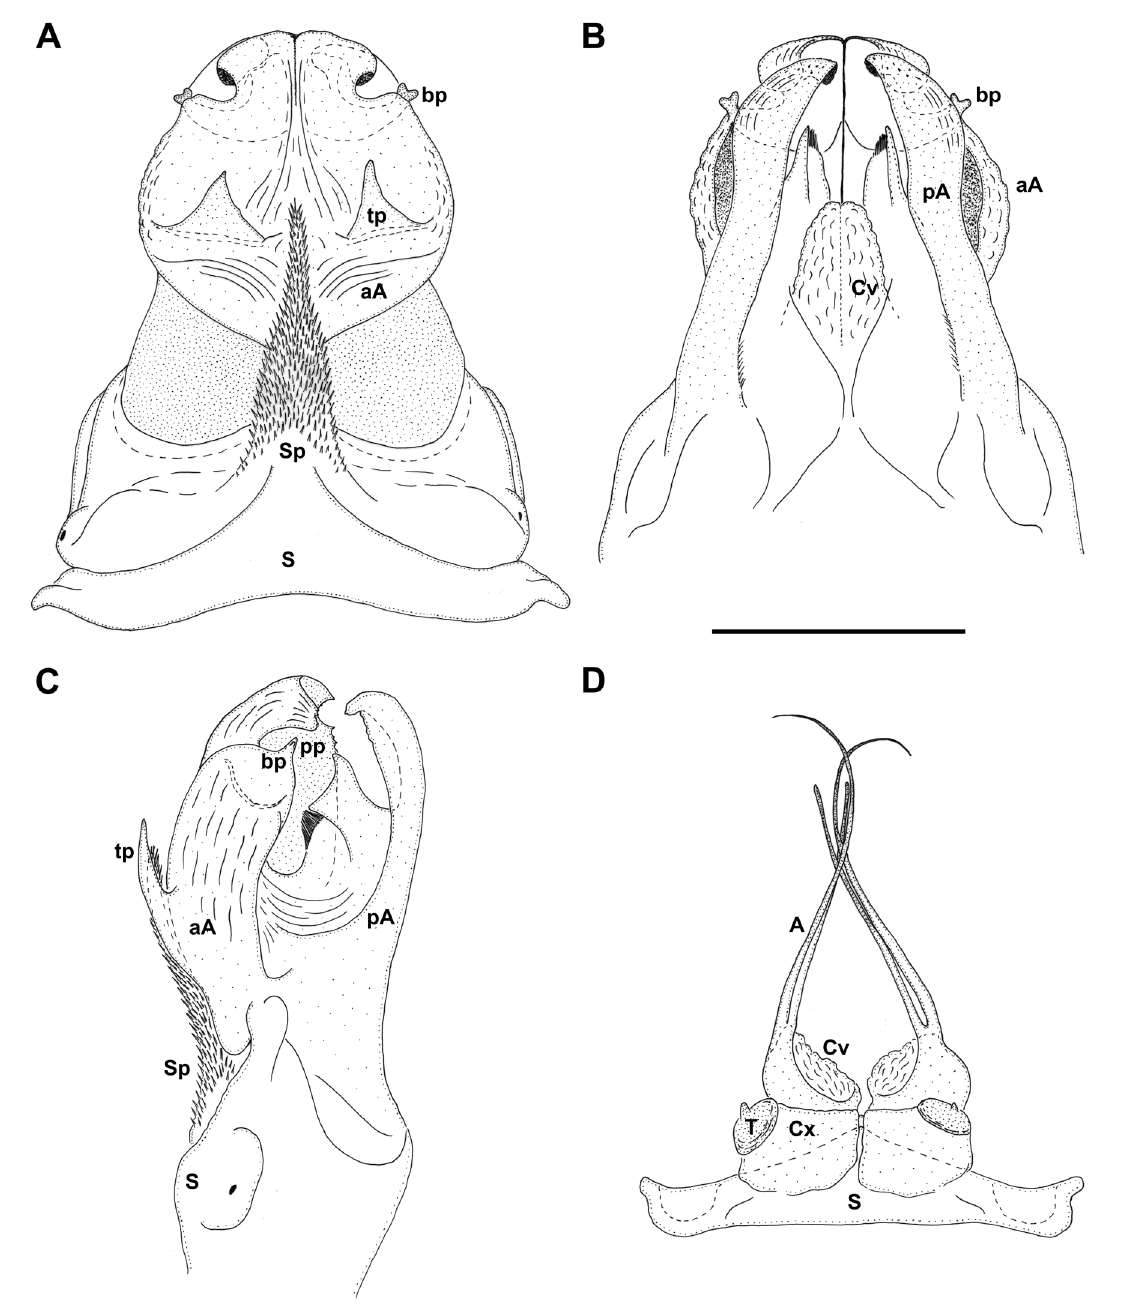
Fig. 5. Caucaseuma strasseri Antić sp. nov., paratype, ♂ (IZB). Gonopods. A–C . Anterior gonopods, anterior, posterior and lateral views, respectively. D . Posterior gonopods, posterior view. Abbreviations: A = angiocoxite; aA = anterior part of angiocoxite; bp = bone-like process of angiocoxite; Cv = coxal vesicle; Cx = coxite; pA = posterior part of angiocoxite; pp = posterior projection of angiocoxite; S = gonopodal sternum; Sp = sternal process; T = telopodite; tp = triangular process of angiocoxite. Scale bar = 0.3